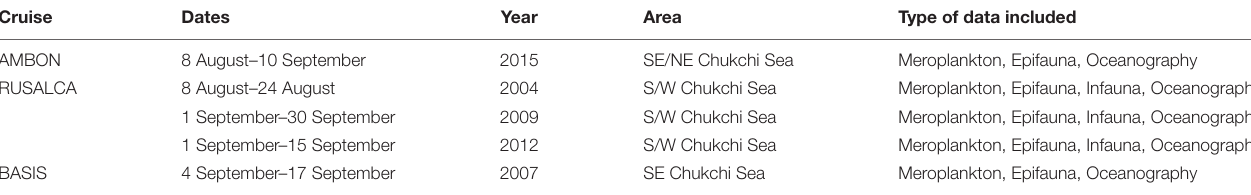
TABLE 1 | List of data sources used in the study.